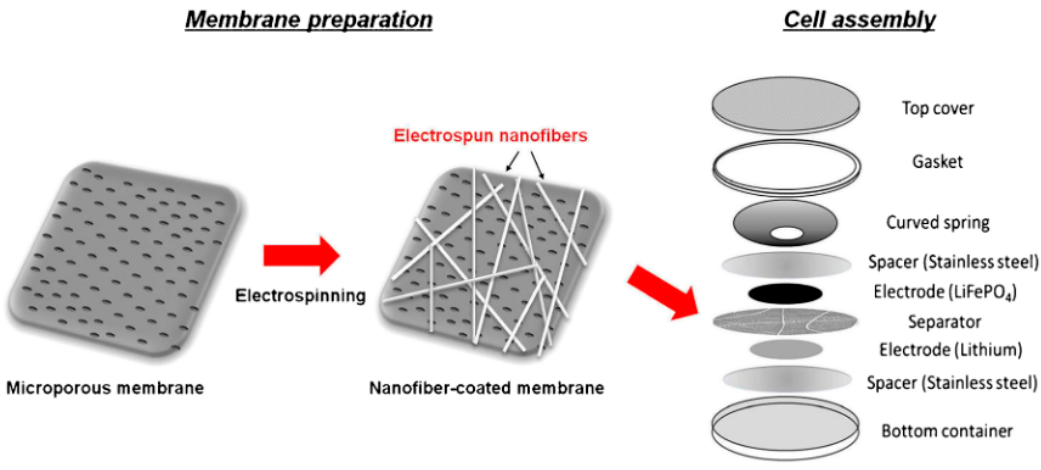
Figure 3. Manufacturing of a testing cell based on PVDF ‐ CTFE separators [47], with copyright permission from Springer Nature.